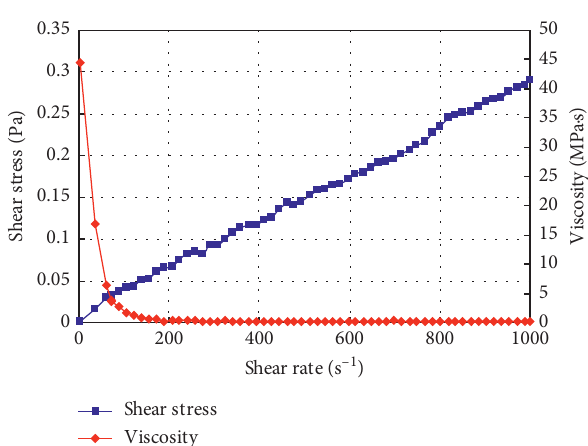
Figure 6: Curves for shear stress and apparent viscosity with shear rate at 60 °